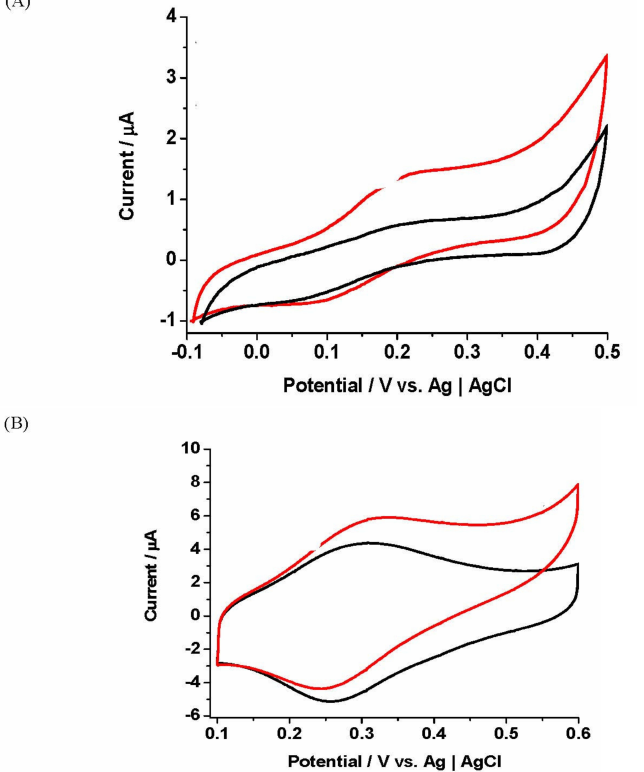
Figure 4. ( A ) Cyclic voltammetry responses of the films of 2-pyrrole in ratio of 1:1 (1 mM:1 mM) and GlutOx electrode towards addition of L -glutamate (10 mM) (red curve) Solution: PBS pH 7.2 (10 mM)-KCl (10 mM) (black curve). Potential sweep, − 0.10–+0.50 V vs. Ag|AgCl, scan rate 0.5 mV s − 1 . Inset: Cyclic voltammetry response of the films and GlutOx at scan rate of 1 mV s − 1 . ( B ) Cyclic voltammetry responses of the films of 6-EDOT in ratio of 1:1 (1 mM:1 mM) and GlutOx electrode towards addition of L -glutamate (10 mM) (red curve) Solution: PBS pH 7.2 (10 mM)-KCl (10 mM) (black curve). Potential sweep, 0–+0.60 V vs. Ag|AgCl, scan rate 0.5 mV s − 1 . Inset: cyclic voltammetry response of the films and GlutOx at scan rate of 1 mV s − 1